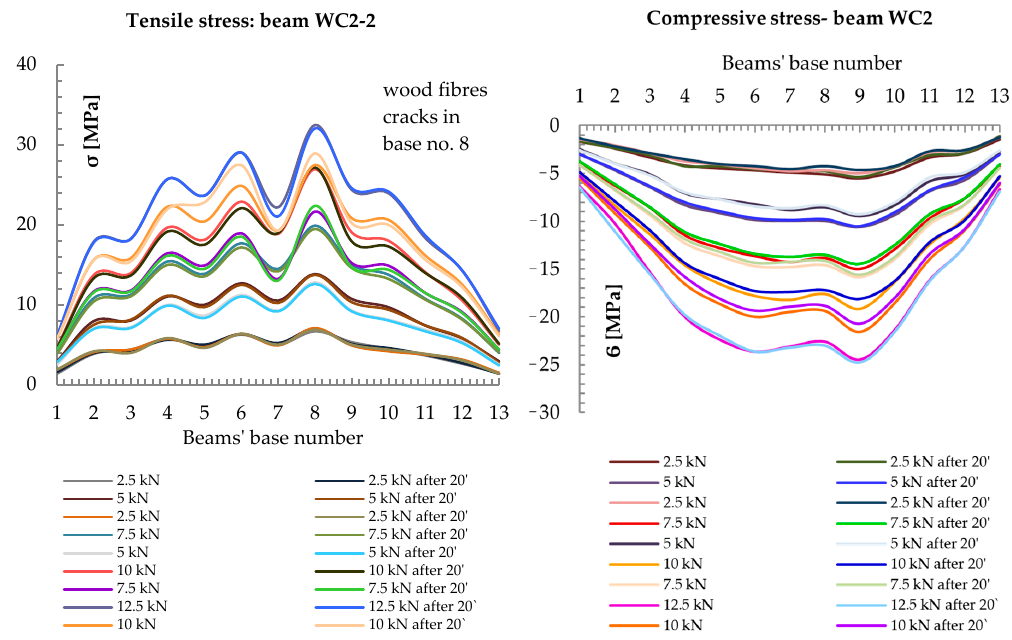
Figure 8. Distribution of normal stresses σ [MPa] in the tension and compression zones along the entire length of the beam reinforced with WC2-2.